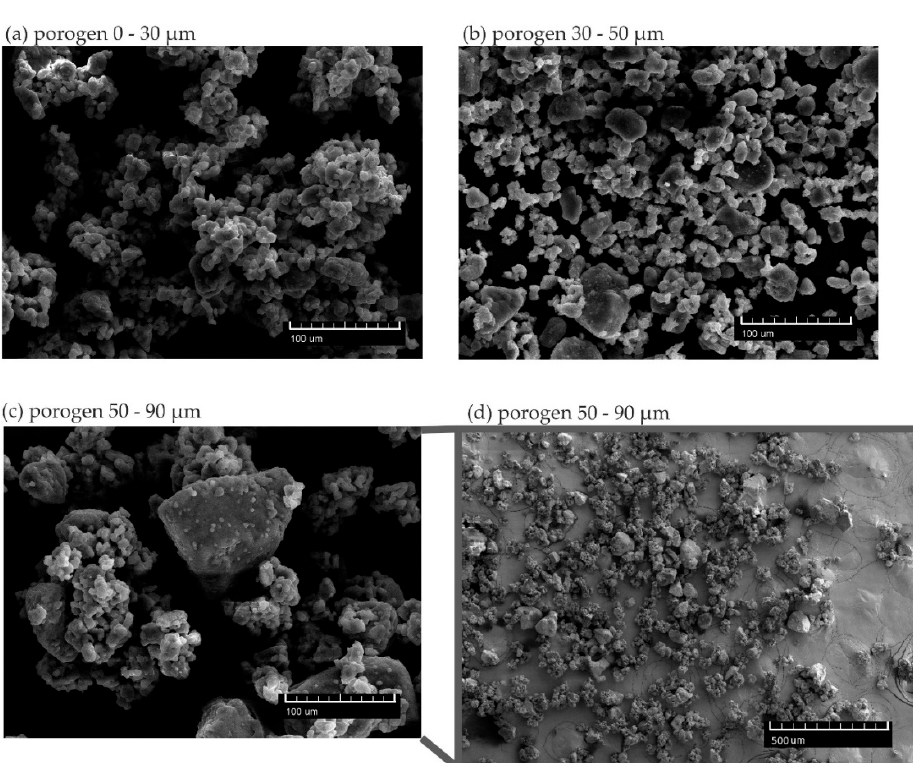
Figure 3. SEM microimages of NaCl particles that serve as a porogen: ( a ) 0–30, ( b ) 30–50, and ( c ) 50– Figure 90 µm. Image ( d ) is a lower magnification image of the 50–90 µm porogen.